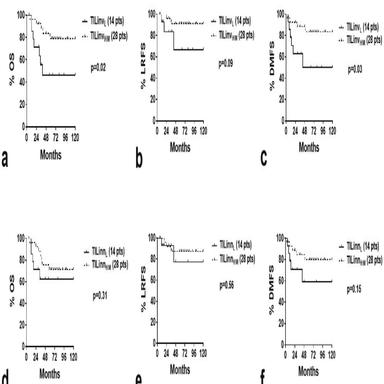
Kaplan Meier survival analysis: (a) Overall disease-specific survival (OS) according to TIL-density in the invading tumor front (HM = high/medium, L = low); (b) Locoregional progression-free survival (LPFS) according to TIL-density in the invading tumor front; (c) Distant metastasis-free survival (DMFS) according to TILdensity in the invading tumor front; (d) OS according to TIL-density in inner tumor areas; (e) LPFS according to TIL-density in inner tumor areas; (f) DMFS according to TIL-density in inner t